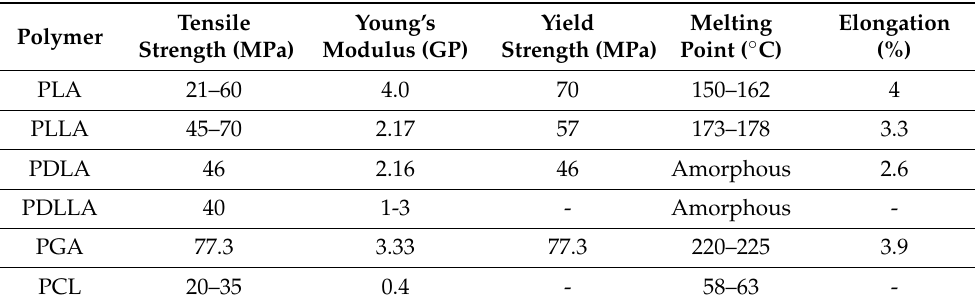
Table 1. The properties of the biodegradable